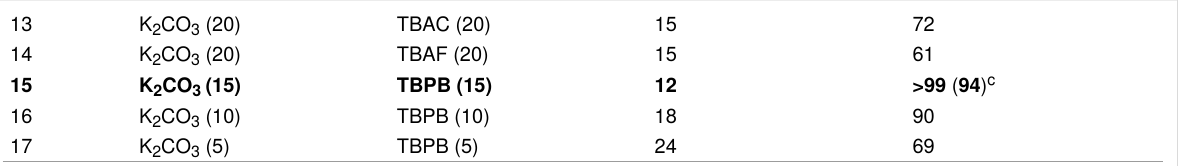
Table 1: Optimization of reaction conditions for the preparation of 2,2,2-trifluoro-1-(1 H -indol-3-yl)ethan-1-ol ( 3a ). a